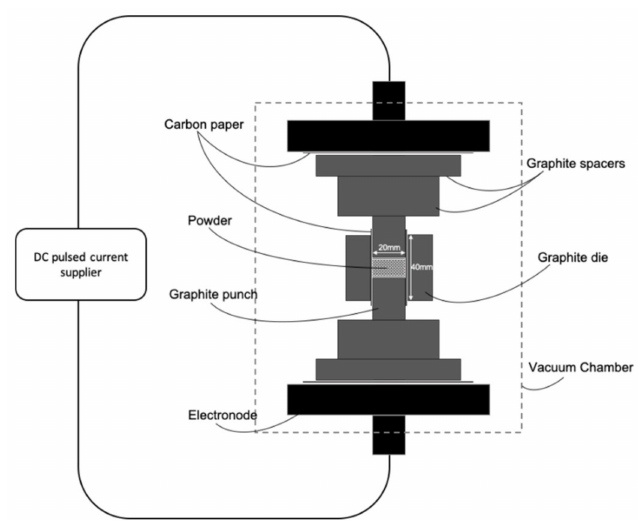
Figure 2. Schematic illustration of spark plasma sintering (SPS) system for manufacturing magnesium– hydroxyapatite